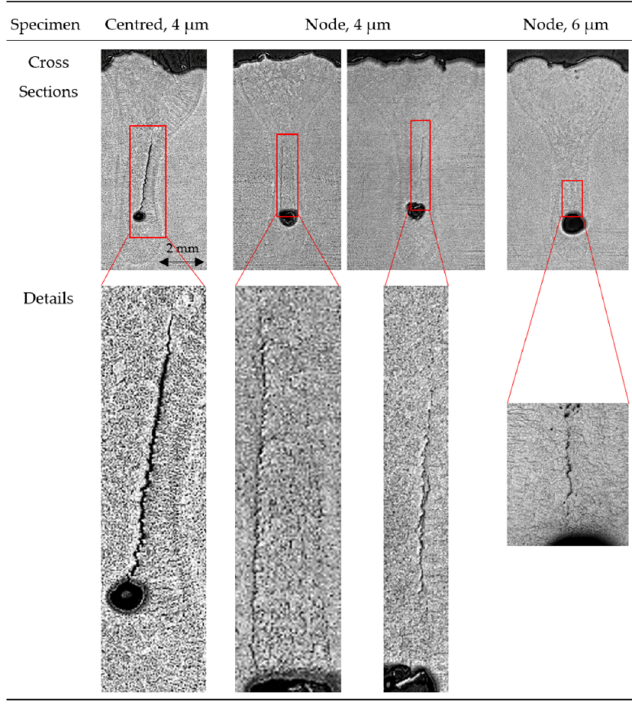
Figure 9. Micrographs of metallographic cross sections of specimens with cracks.